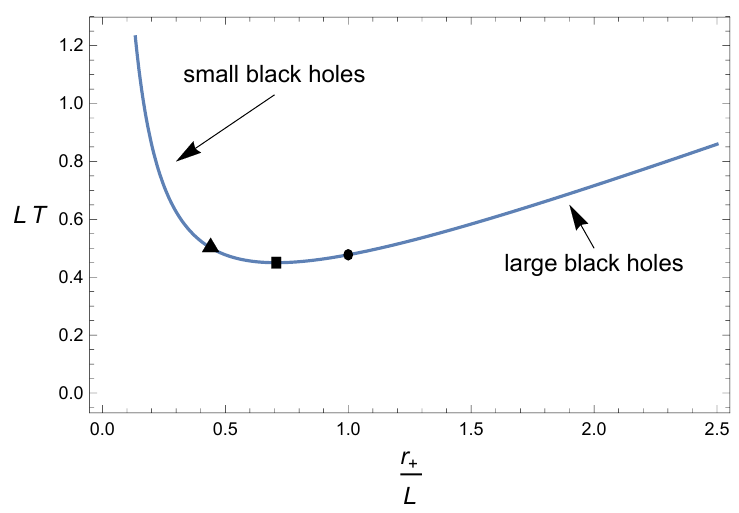
Figure 1 . Black hole temperature as a function of radius for d = 5. Approaching from the large black hole branch, the circle indicates the Hawking-Page phase transition to thermal AdS 5 in the canonical ensemble, the square is the point at which the heat capacity becomes negative, and the triangle is the Gregory-La(cid:13)amme type instability [7]. As d gets larger, the points approach each